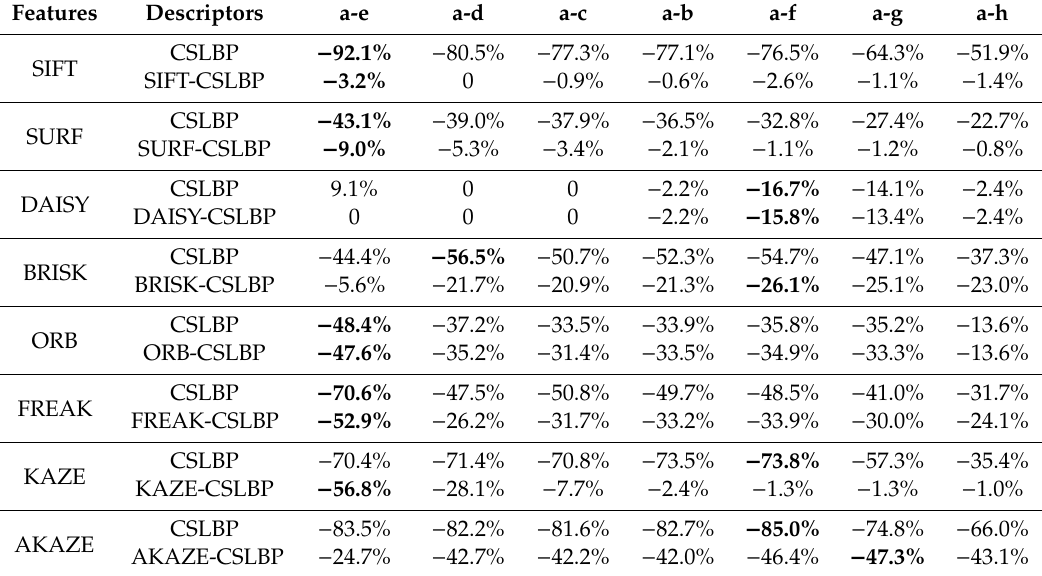
Figure 12. Matching results of the precision of Bikes sequence for the eight original, the CSLBP, and the improved descriptors. The X label represents the matched images of Bikes sequence, and the Y label denotes the precision for each descriptor. ( a ) SIFT features; ( b ) SURF features; ( c ) DAISY features; ( d ) BRISK features; ( e ) ORB features; ( f ) FREAK features; ( g ) KAZE features; ( h ) AKAZE features. Table 3. The reduced values of recall for the CSLBP and the combined descriptors compared to the original descriptors of Bikes sequence.